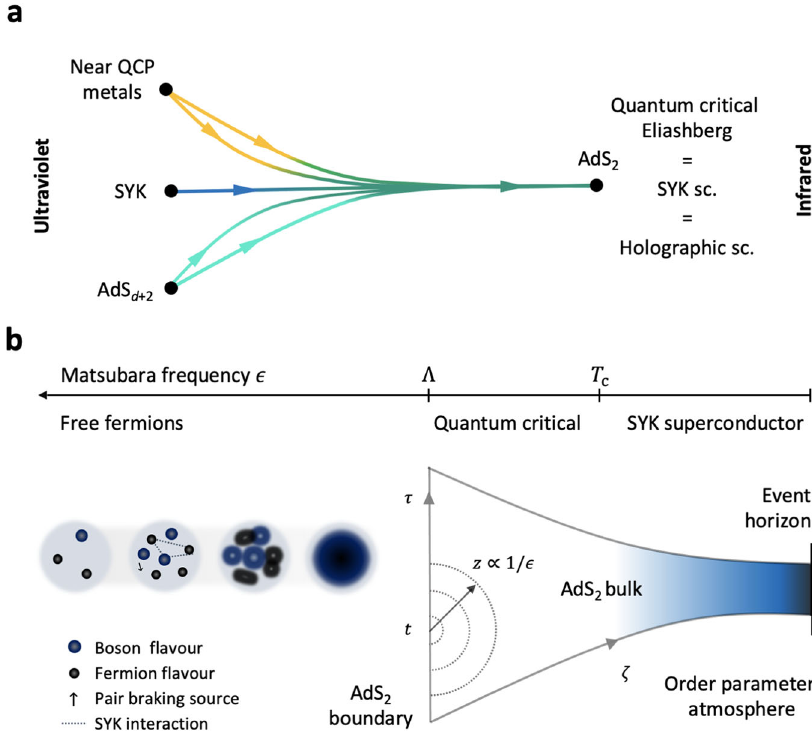
Fig. 1 The emergence of the dual holographic theory from the SYK superconductor. a The semi-universal low-energy holographic action equal to quantum critical Eliashberg theory describing the IR of holographic superconductors (AdS d + 2 ), SYK superconductors, and metals near quantum critical points. b Below the UV scale Λ , a strongly coupled quantum-critical fl uid forms out of interacting fermions and bosons. Below this scale, the fl uctuating order parameter becomes a scalar fi eld with emergent AdS 2 gravity and forms an atmosphere around a black hole event horizon. The frequency ϵ of the relative time τ 1 − τ 2 and the absolute time t = ( τ 1 + τ 2 )/2 of SYK pairing fi elds F τ 1 ; τ 2 ð Þ